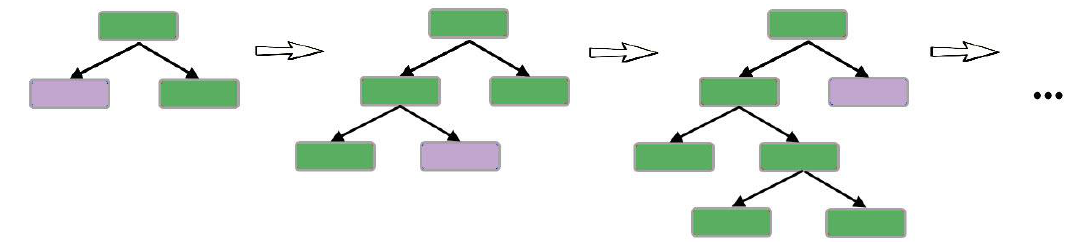
Figure 6. Schematic diagram of LightGBM classifier.